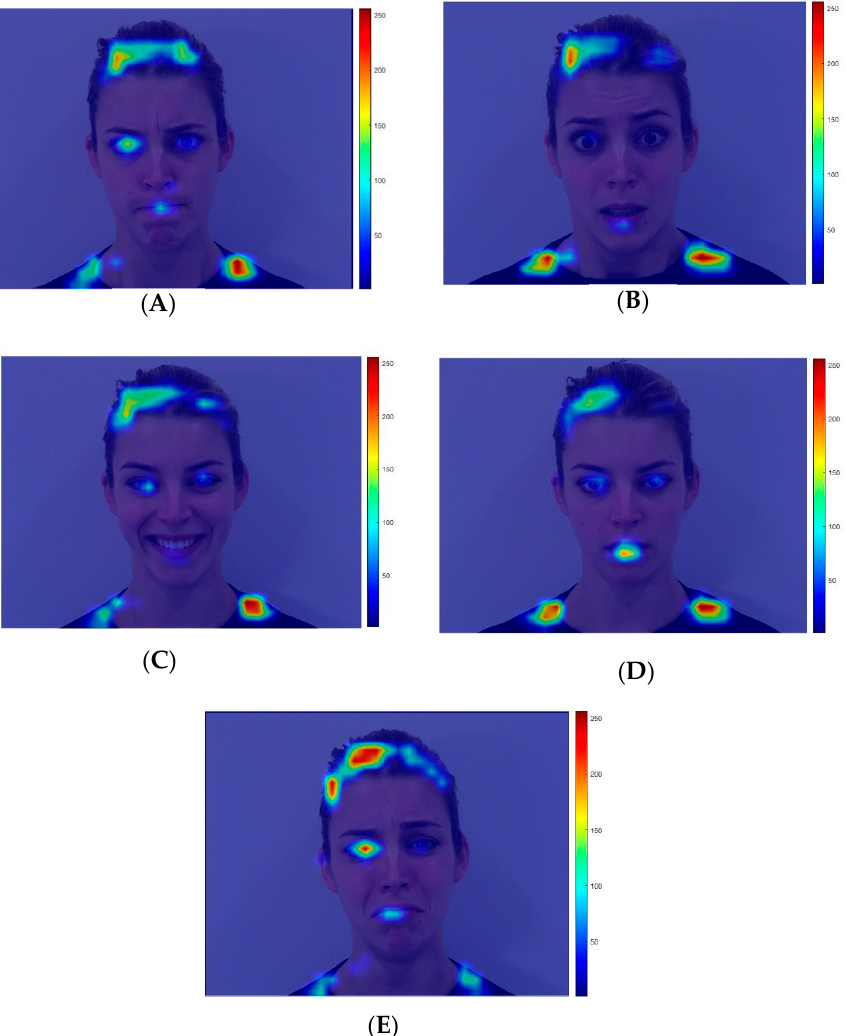
Figure 4. Heat maps representing visual saliency derived from the Matlab Saliency Toolbox [45] overlaid on ( A ) Angry; ( B ) Fearful; ( C ) Happy; ( D ) Neutral; and ( E ) Sad peak facial expressions of one identity. Hot colors (e.g., red, yellow) represent higher saliency locations and cool colors (e.g., blue) represent lower saliency locations.